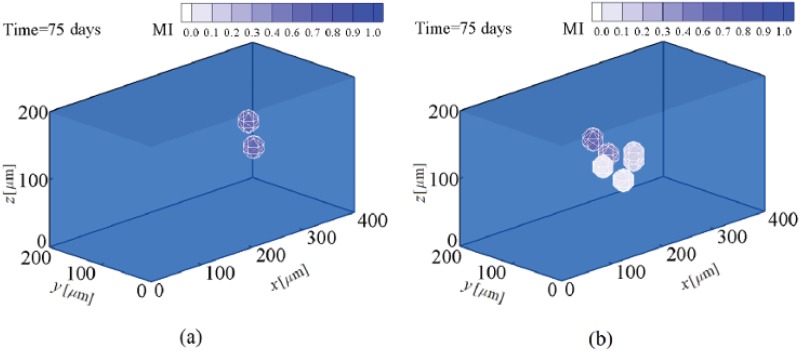
Neuroblast proliferation in soft substrates.a- 0.1 kPa and b- 1 kPa stiffness (see also S4 Video).